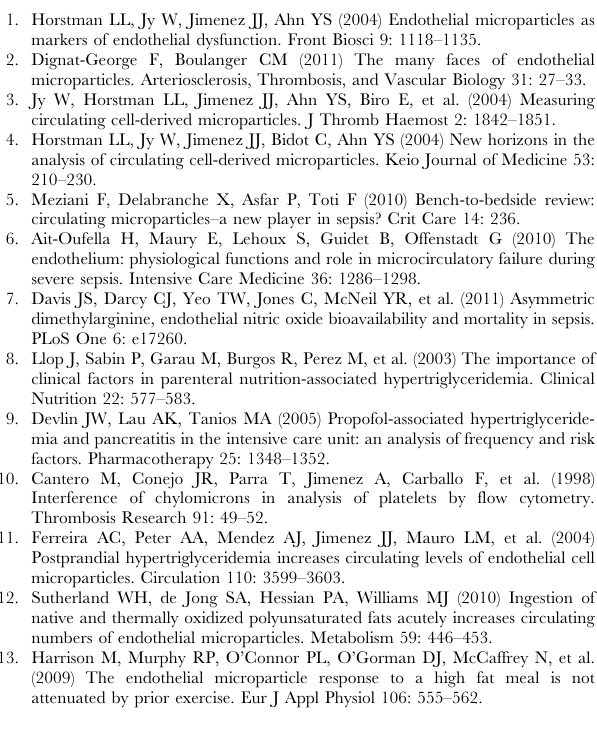
Figure 7. Microparticle gating strategy. For the detection of EMP, PPP was incubated at 4 u C for 20 minutes with CD31-PE (BD Biosciences, Erembodegem Belgium) and CD42b-FITC (BD Bioscience, Erembodegem Belgium), both 0.22 m m filtered and azide free. Samples were diluted in 0.22 m m filtered FACSflow (BD Biosciences, Erembodegem Belgium), to allow sample acquisition at less than 1000 events/sec on low flow rate. Samples were analyzed on a FACSCantoII (BD Biosciences, Erembodegem Belgium). Antibodies were titrated, and isotype fluorescence-minus-one for FITC (C) and PE (D) and unstained samples (A) were run as controls. EMP were defined as particles smaller than 1 m m that were CD31-positive and CD42b-negative (B). For illustrative reasons the MP gate is shown as a rectangular gate. For the settings of the dimension criteria see figure